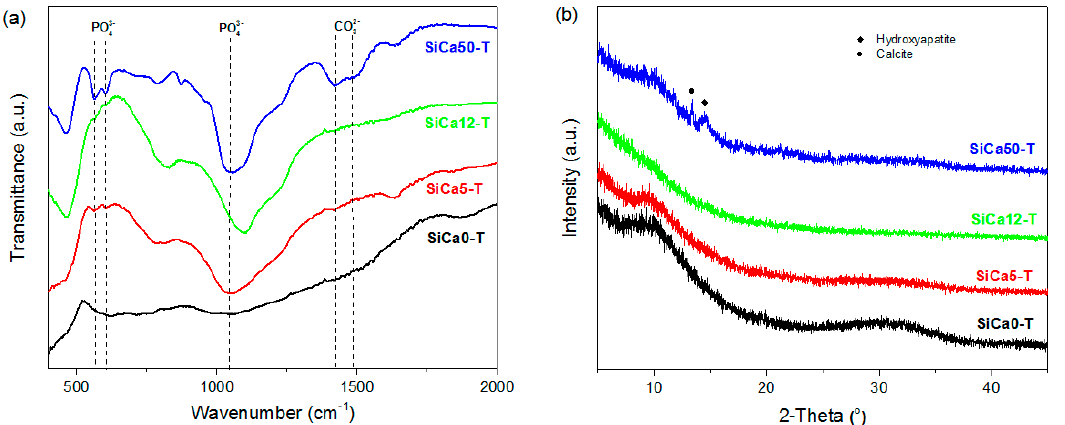
Figure 8. ( a ) FTIR spectra and ( b ) XRD diffractograms of silicon oxycarbide samples after seven days of SBF test.